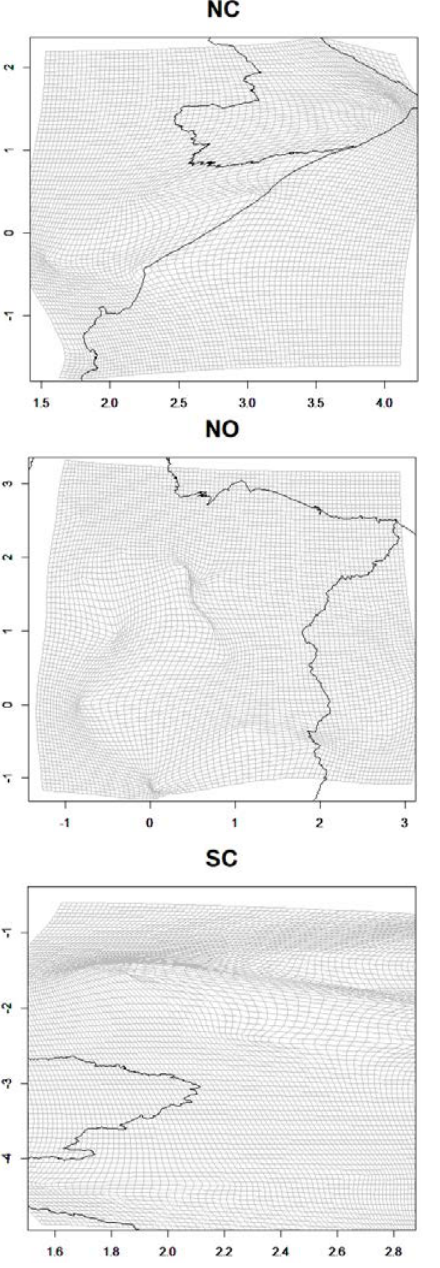
Figure 6. Spatial estimation of D in the NC, NS, NO, SS and SC regions. The horizontal and vertical lines represent a fine grid representing the area of interest. The angle of intersection between the horizontal and vertical lines should be 90 degrees when the spatial process is isotropic. Otherwise, the spatial process will be anisotropic.